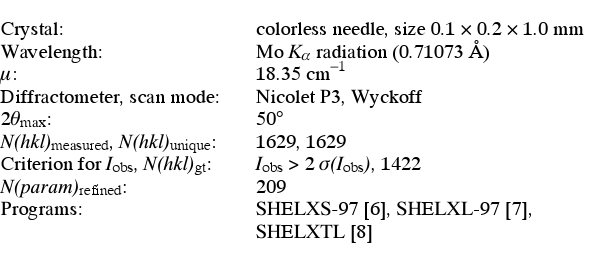
Table 1. D a t a collection a nd h a ndling.